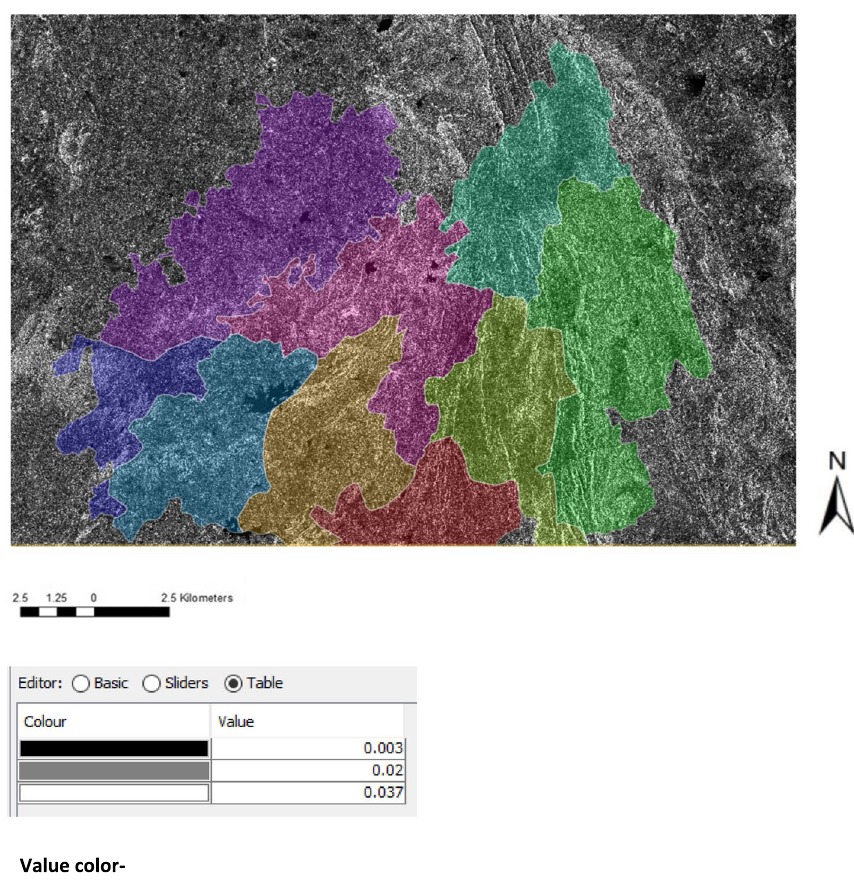
Fig. 8 Sentinel-1A-GRD Multi-Looked data (VH Polarisation) of the Udaipur